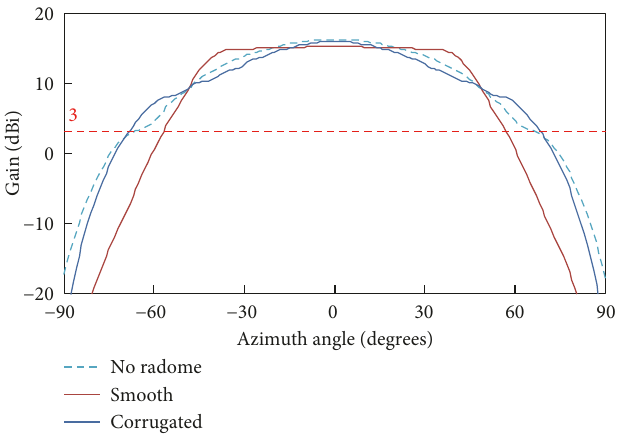
Figure 3: 3dBi beam width comparison: smooth-walled radome versus corrugated radome.